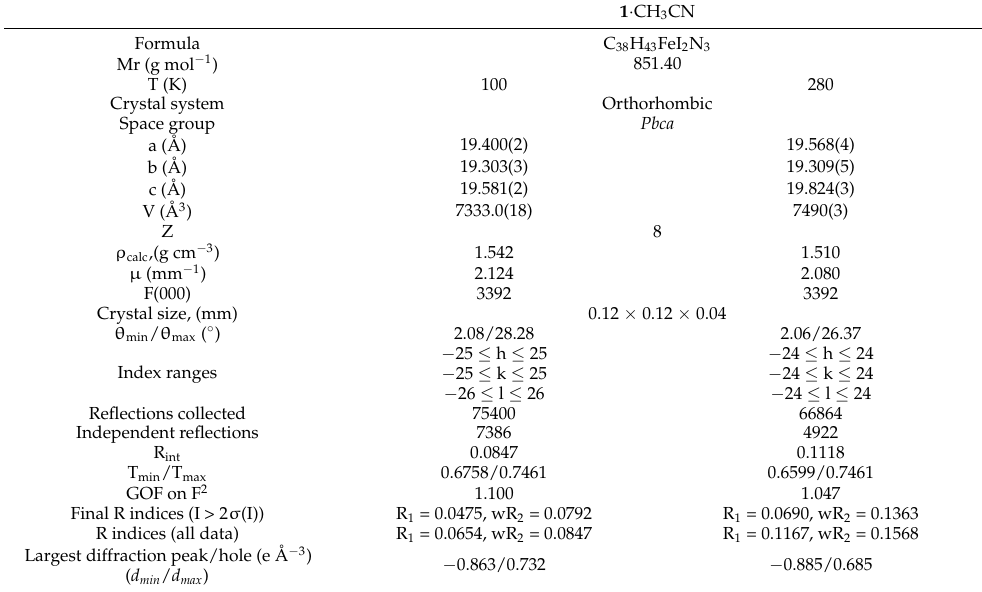
Figure 1. Molecular structure of 1 . Thermal ellipsoids are drawn at 50% probability level. Hydrogen atoms and solvent molecule are omitted for clarity. Table 1. Crystal data and structure refinement details for compound 1 · CH 3